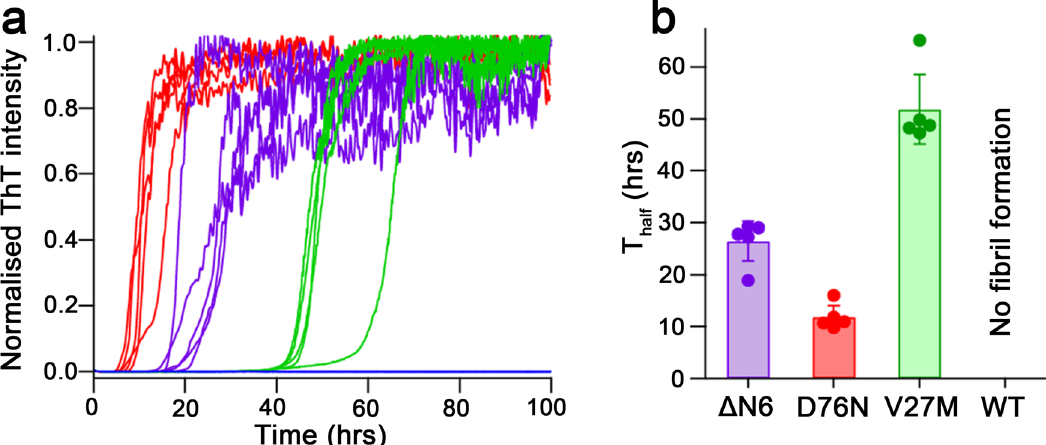
Fig. 1 | ThT kinetics of amyloid formation for the β 2 m variants at pH 6.2. bars indicate standard deviation from the individual ThT runs (shown as fi lled a Normalised ThT fl uorescence curves for WT- β 2 m (blue), β 2 m- Δ N6 (purple), spheres)), indicating the relative rate of amyloid formation for each protein. WT- β fi ve repeats ( n =5 β β 2 m-D76N (red) and 2 m-V27M (green) at pH 6.2, showing 2 m does not form amyloid at pH 6.2 during the 100h reactions. Source data are technicalreplicates)foreachprotein. b BarchartofthemeasuredmeanT half values provided as a Source Data fi and ( n =5 technical replicates, using different batches of the protein). The error